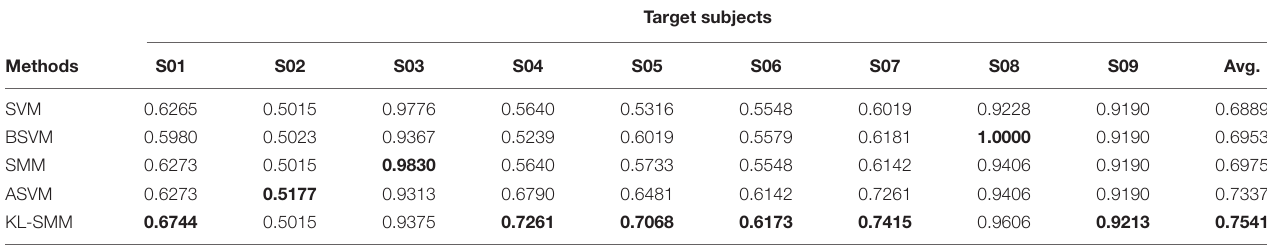
TABLE 3 | Comparison of F1 using 14 labeled target EEG data in Exp. 1 .